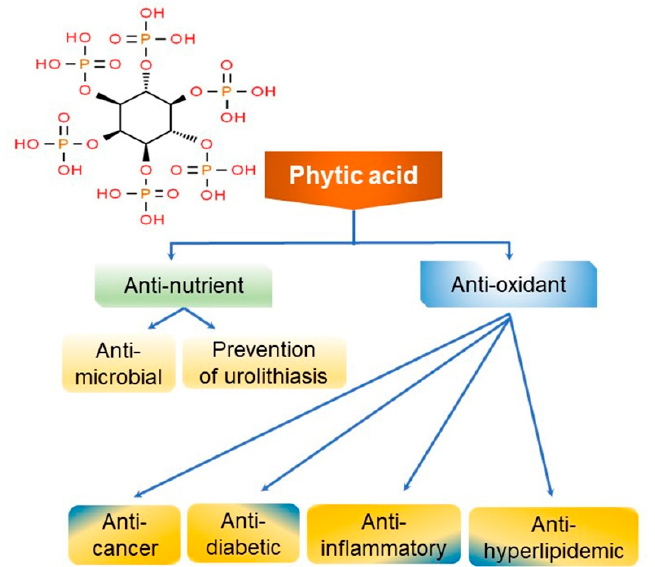
Figure 7. Structure and schematic representation of clinical properties of phytic acid